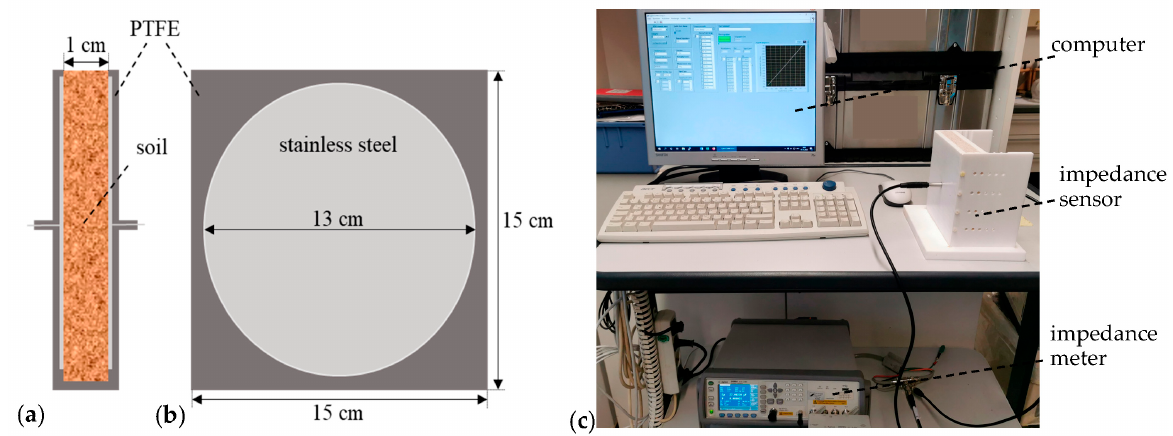
Figure 2. Parallel-plate impedance sensor. ( a ) Cross section. ( b ) View of the right plate from the left. ( c ) Photograph of the setup with impedance meter and